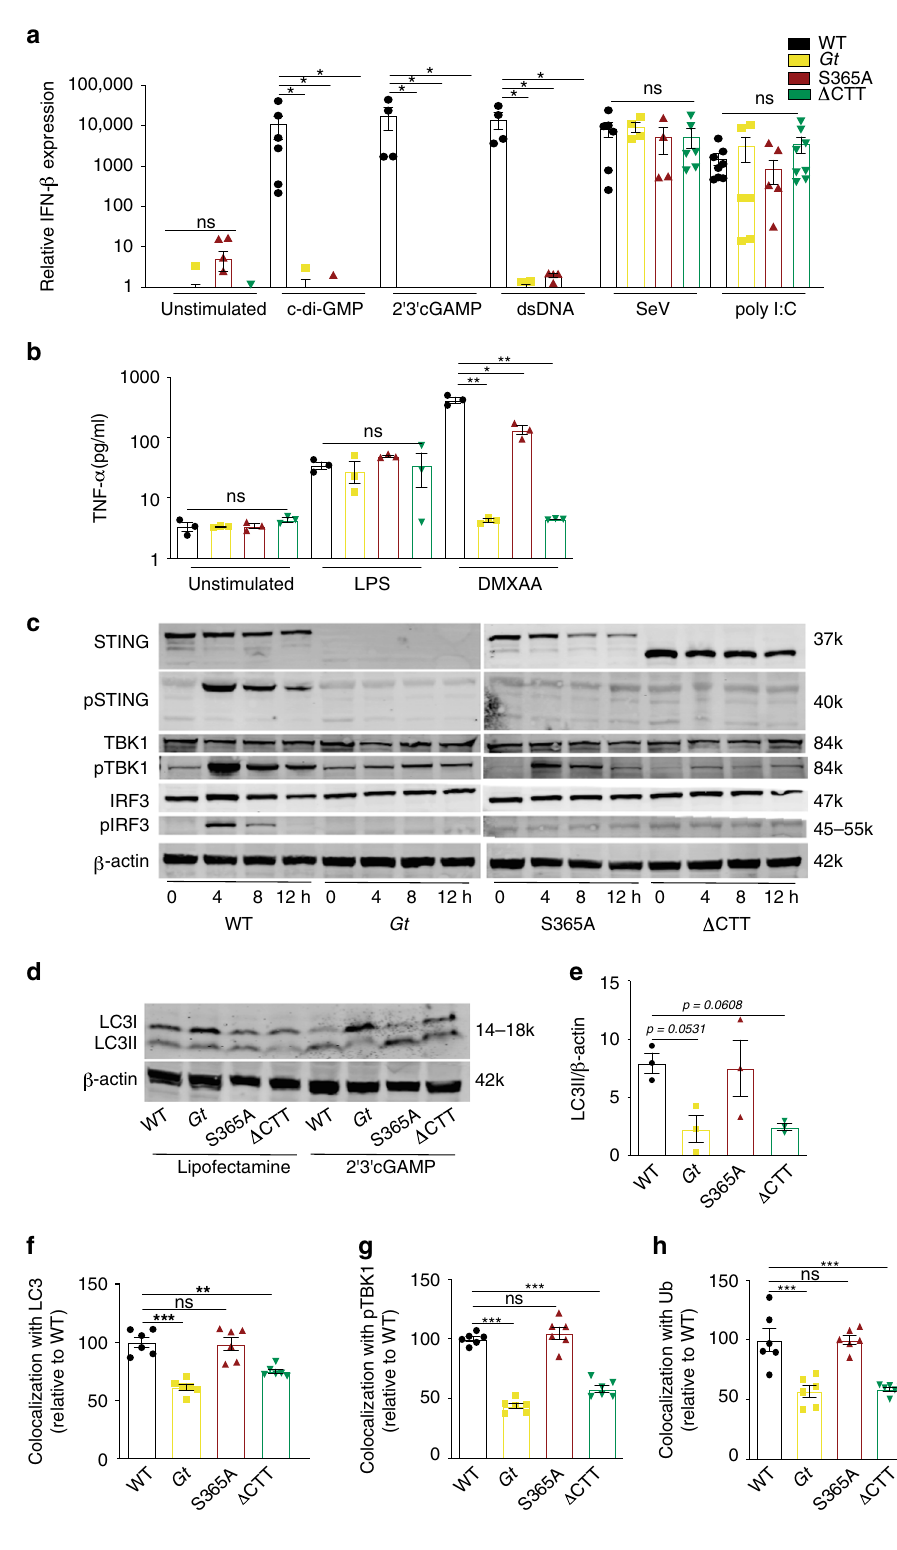
is independent of S365-IRF3 activation and type I IFN responses but largely requires the CTT. To con fi rm this result using a more quantitative assay, we assessed colocalization of LC3 puncta and cytosolic DNA with an automated image quantitation pipeline. Primary macrophages were transfected for 6 h with Cy3-labeled DNA and colocalization with LC3 puncta was quanti fi ed by immuno fl uorescence. STING-de fi cient Gt and Δ CTT cells